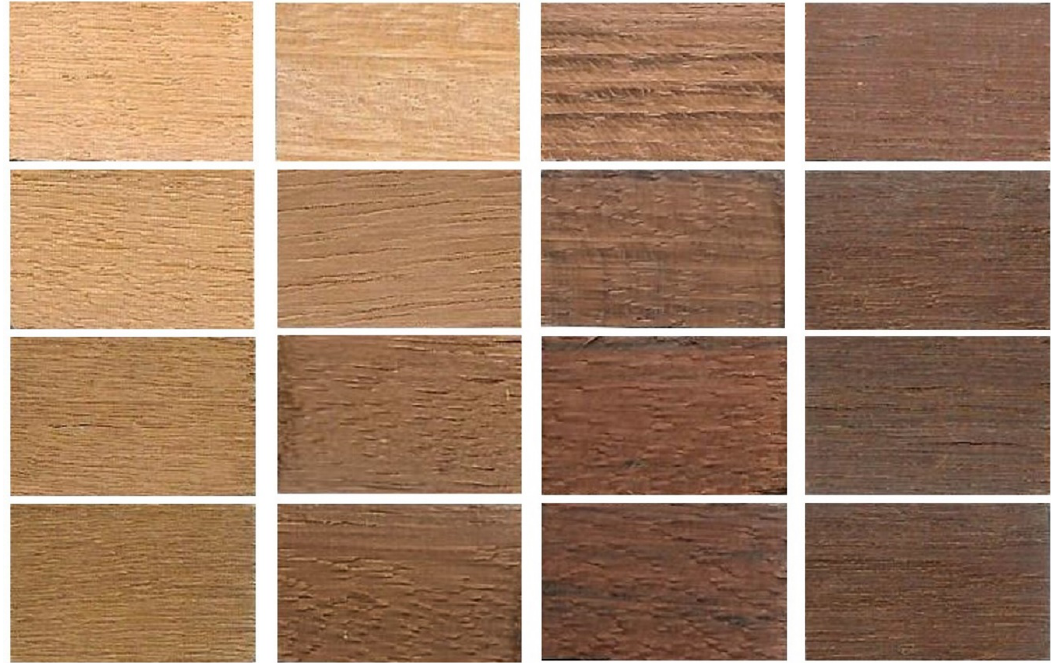
Figure 1. Visual comparison of contrast among the exposed and non-exposed surface (from left: garapa, tatajuba, courbaril and massaranduba; from top: fresh wood, after 24 h of UV irradiation, after 1 cycle of artificial weathering, after 4 cycles of artificial weathering).